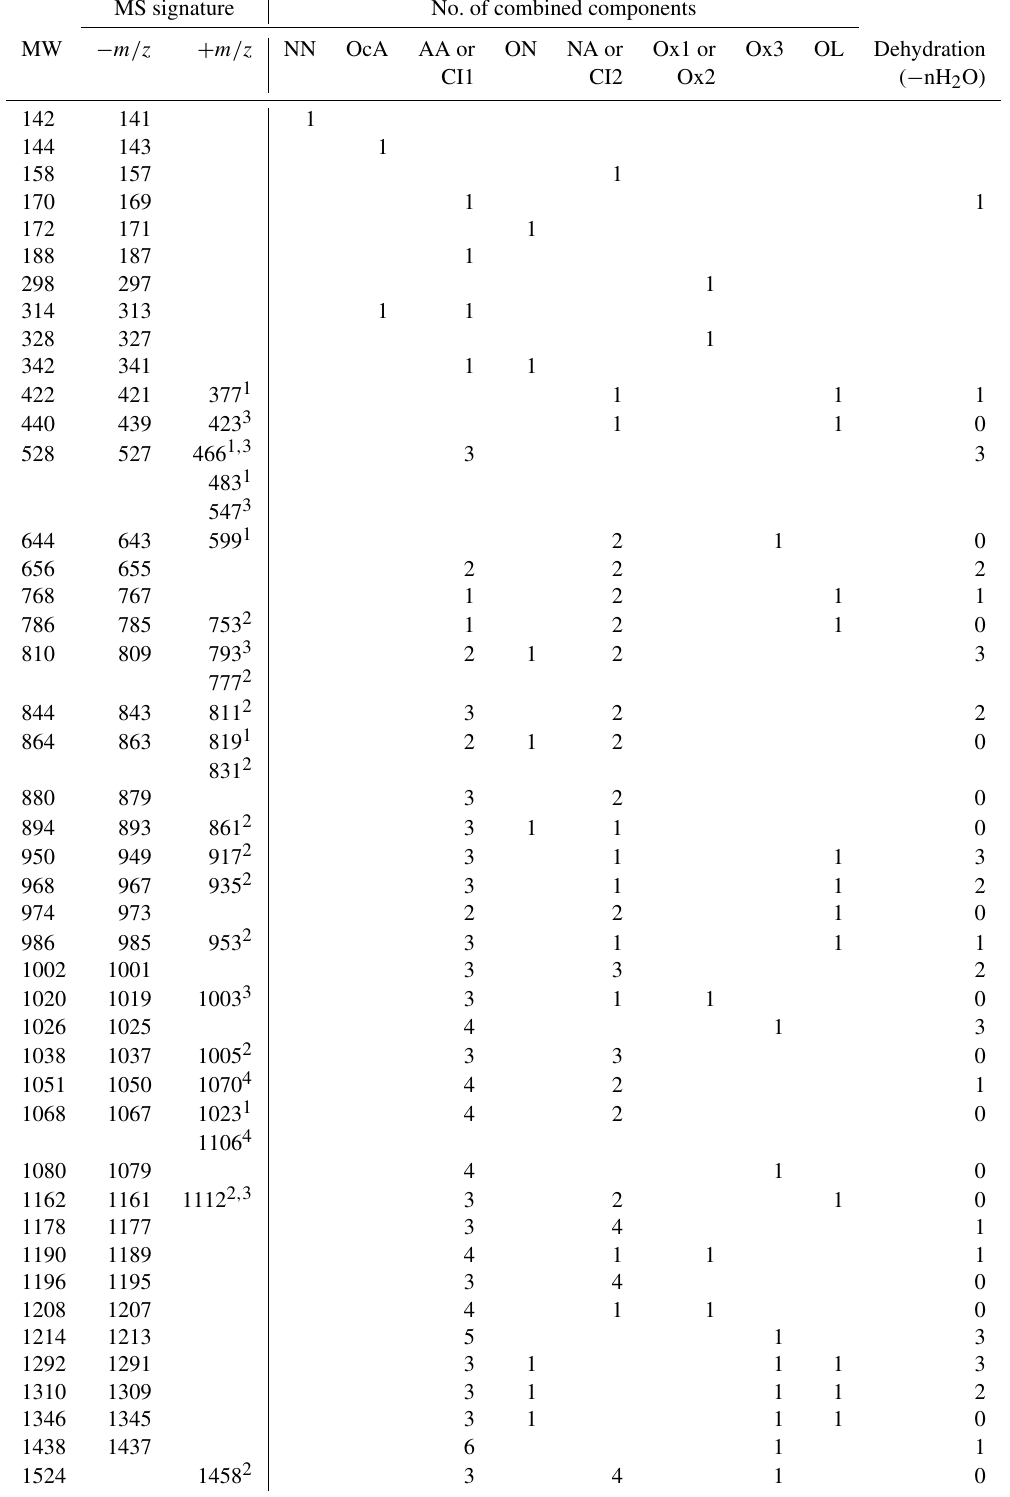
Table 1. A summary of proposed components and possible propagator combinations contributing to the observed mass spectral peaks corresponding to 44 oxidation products of the OL-O 3